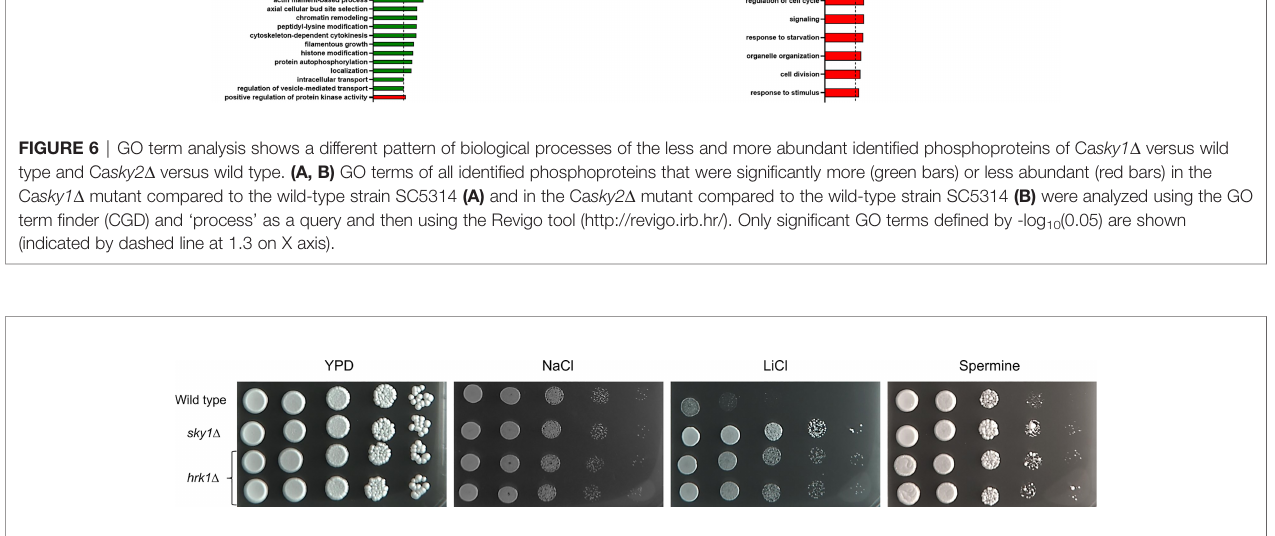
FIGURE 7 | Deletion of HRK1 confers resistance to high salt and toxic spermine levels. YPD overnight cultures of the strains were adjusted to an optical density (OD 600 ) of 1.0. For hrk1 D two independently generated mutants were tested. Serial 10-fold dilutions were spotted on YPD agar plates containing the indicated stressor and incubated for 2 days at 37°C. Plates contained 1.8 M NaCl, 0.3 M LiCl or 12.8 mM